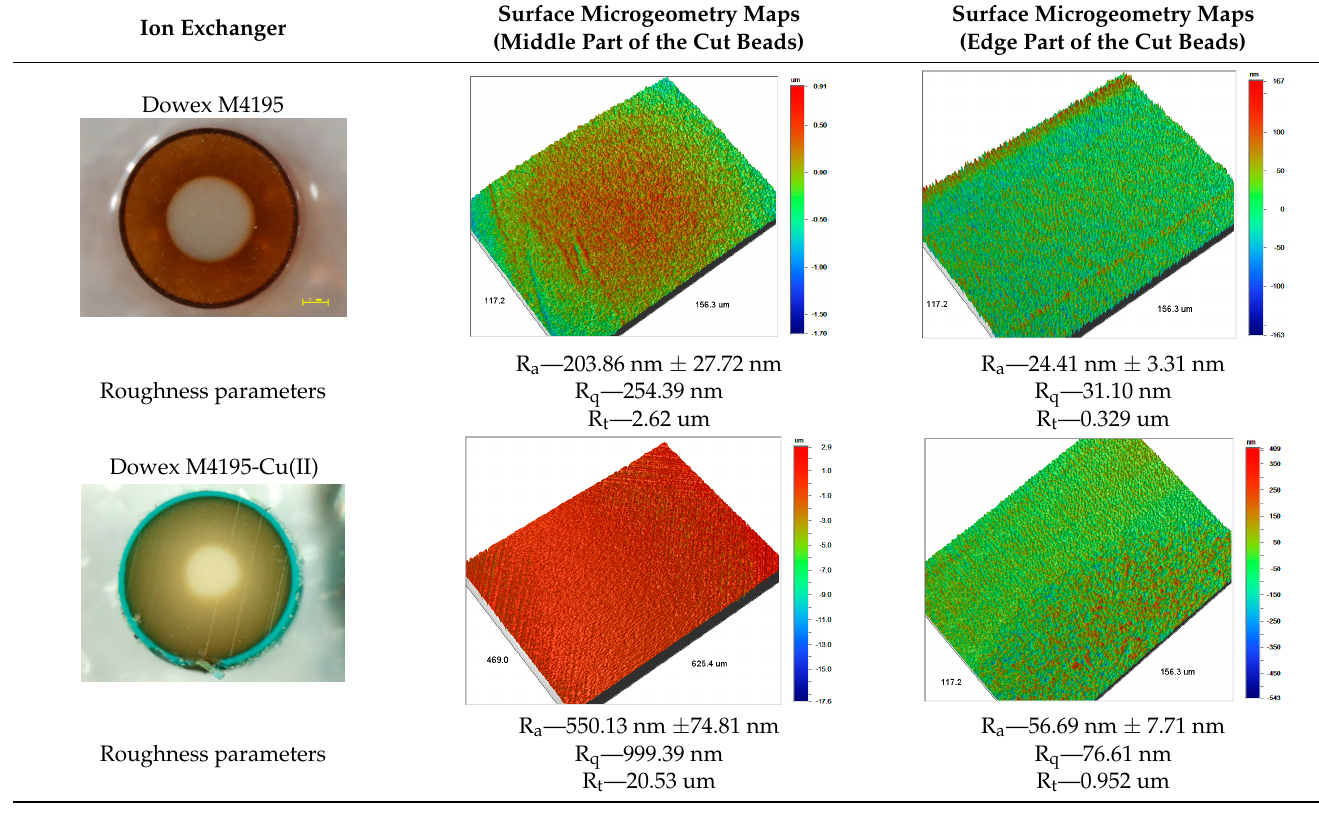
Table 3. Surface microgeometry and roughness parameters of Dowex M 4195 before and after the sorption of Cu(II).